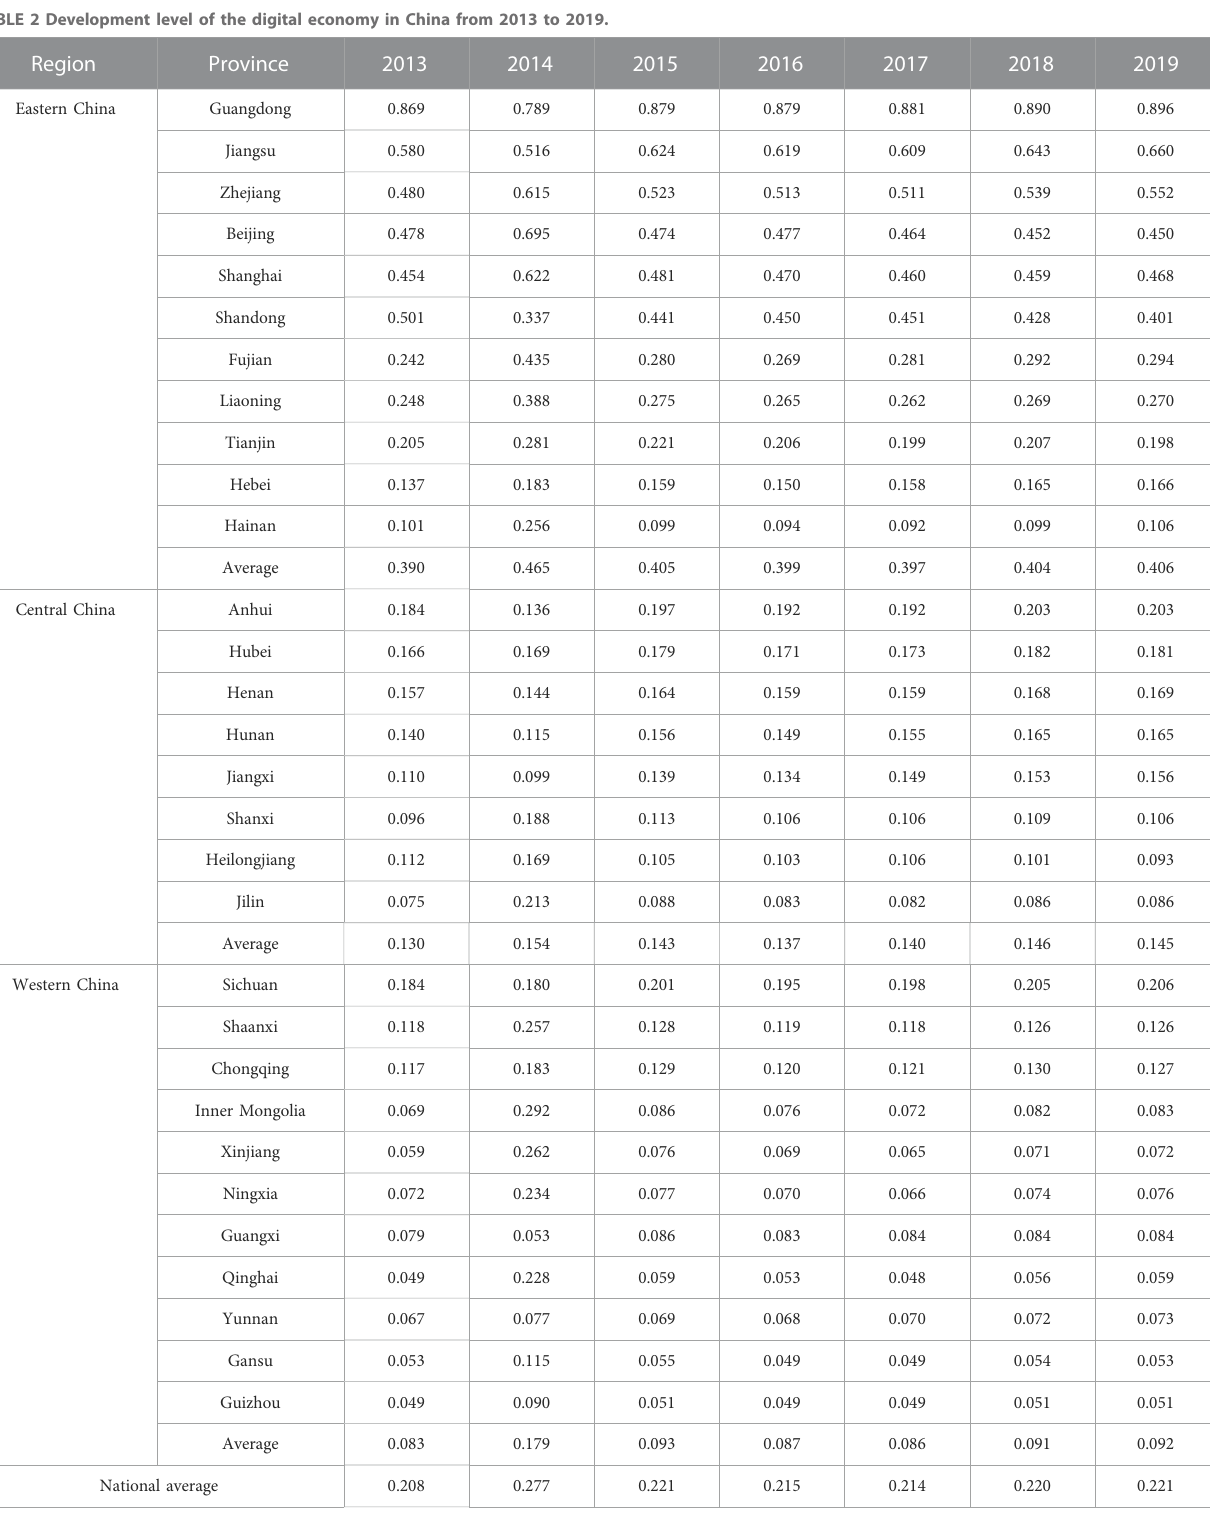
TABLE 2 Development level of the digital economy in China from 2013 to 2019.